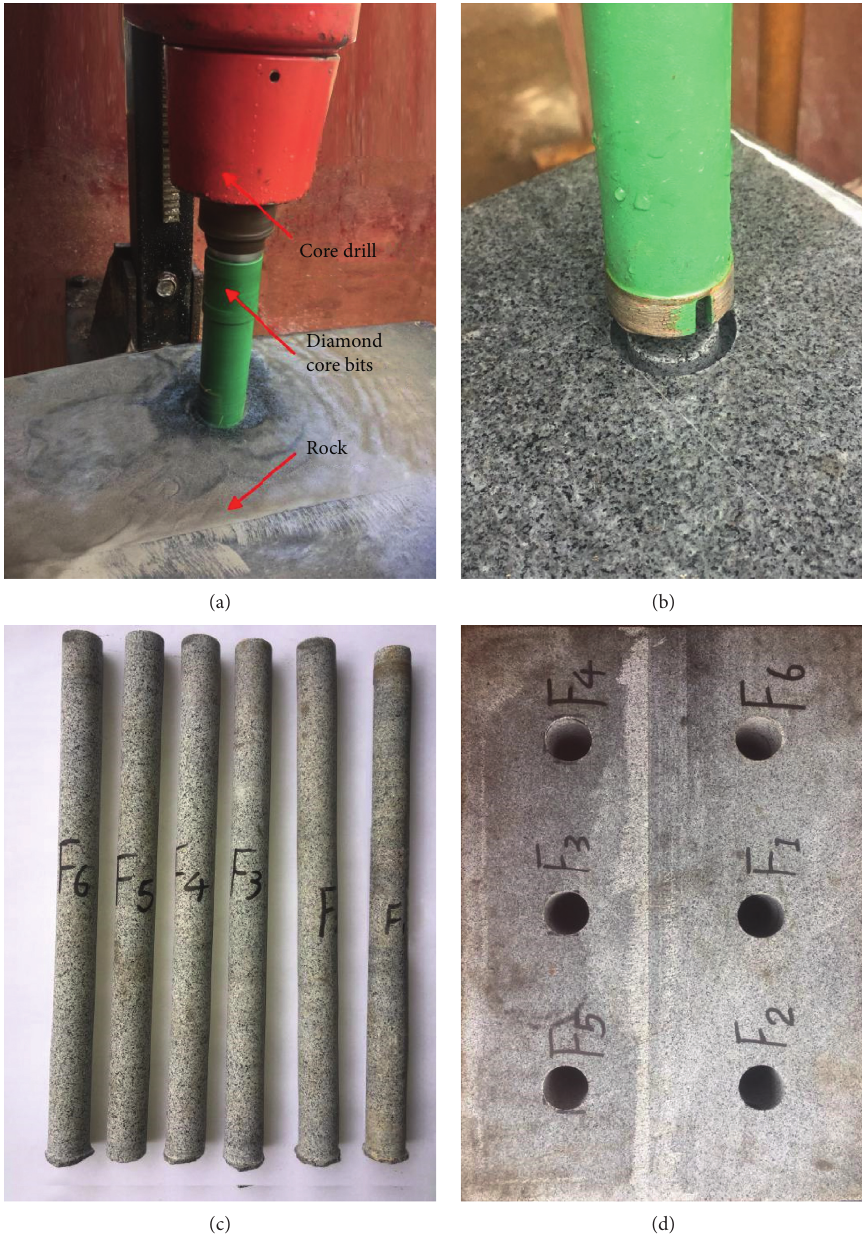
Figure 7: Nonimpact drilling process: (a) core drilling; (b) close-up photograph of coring process; (c) cores removed from block F; and (d) block F after coring with diamond